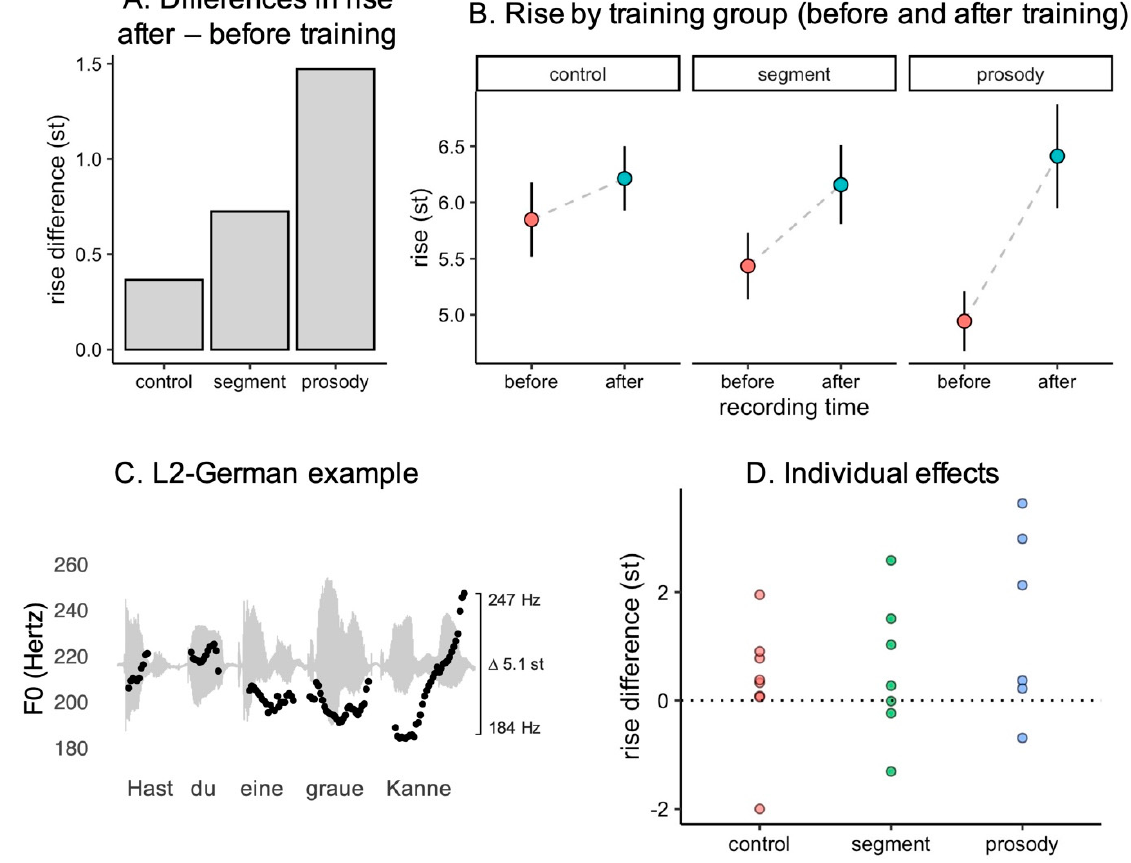
Figure 1. Differences in means before and after training ( A ), means and SE before and after training ( B ), example contour from one L2 speaker ( C ), separate differences in rise for speakers ( D ), where each dot corresponds to one speaker.